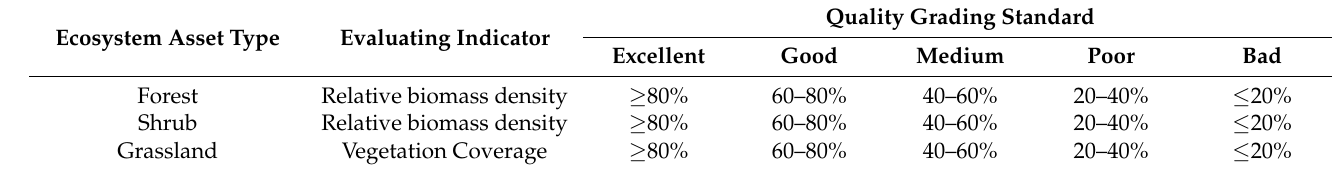
Table 1. Grading standards for ecosystem asset